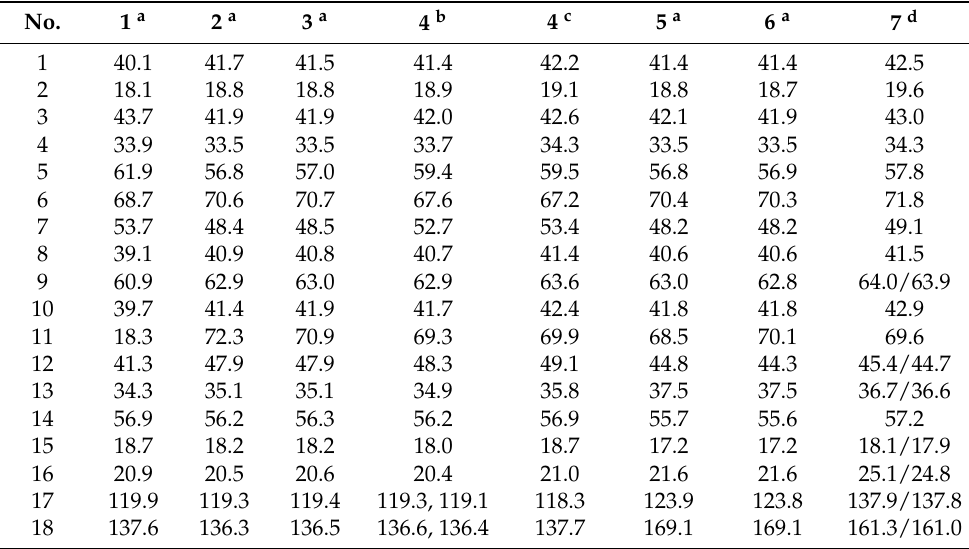
Table 2. 13 C NMR spectroscopic data (100 MHz) for compounds 1 – 7 ( δ in